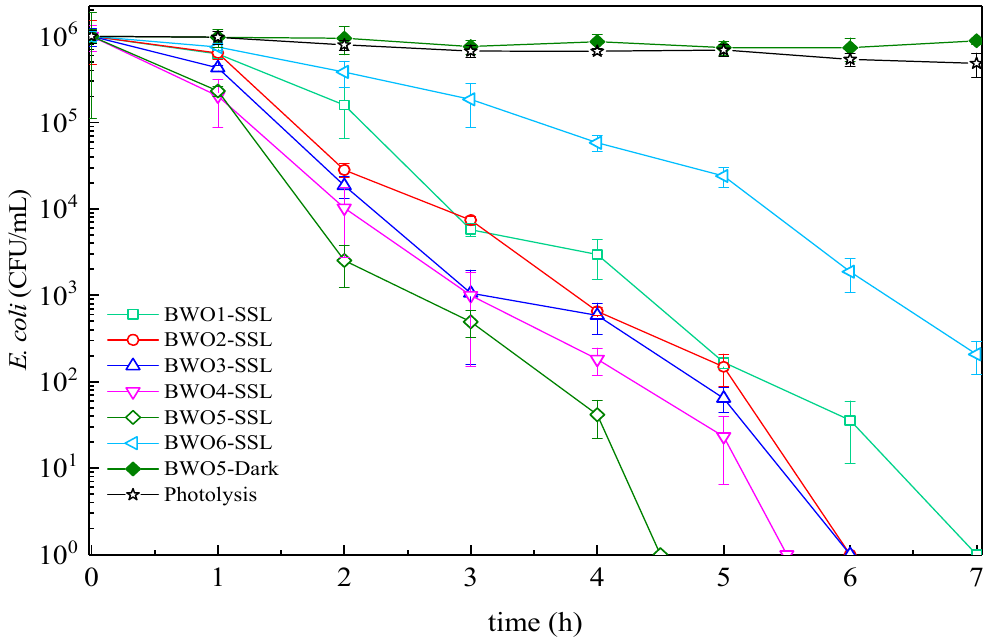
Figure 5. Photocatalytic inactivation of Escherichia coli in aqueous dispersions on different Bi 2 WO 6 samples in the dark and under simulated solar light (SSL). Experimental conditions: [Catalyst] 0 = 0.2 g/L, [bacteria] 0 = 2 × 10 6 Colony Forming Units (CFU)/mL and light intensity: 48 mW/cm 2 .